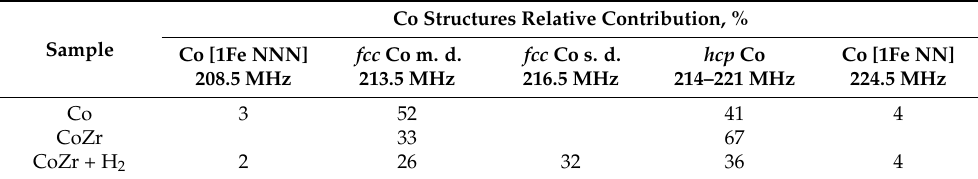
Table 3. Relative contributions of different structures of metallic Co according to decomposition of the experimental 59 Co IF NMR spectra.